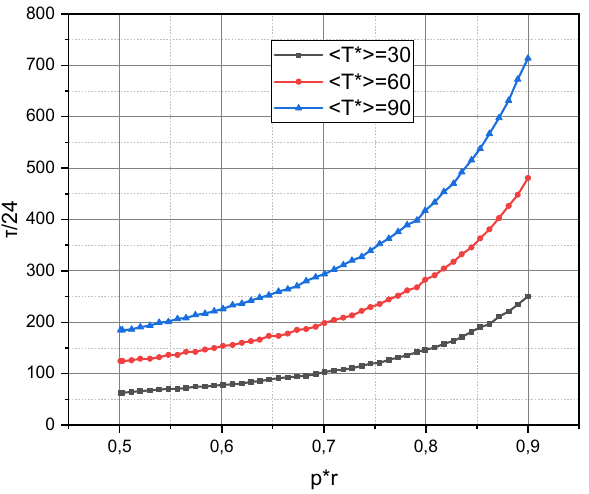
Figure 3. Calculated dependences τ ≈ = f